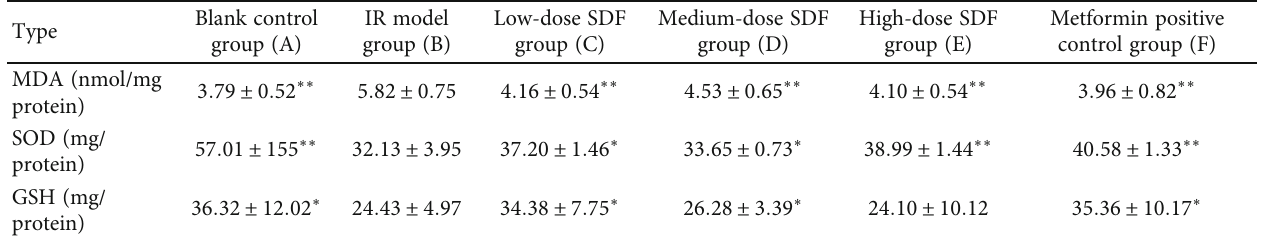
Table 5: MDA content and T-SOD and GSH activities of IR in HepG2